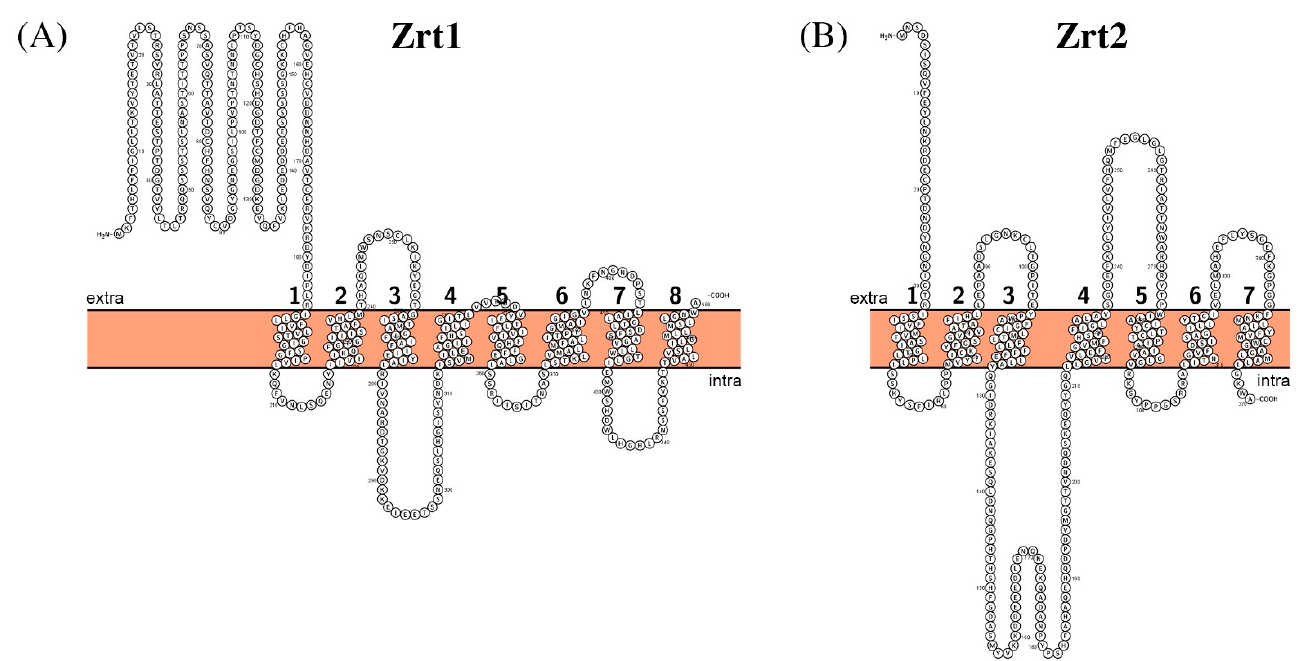
Figure 7. Schematic representation of the proposed secondary structure and topology of Zrt1 ( A ) and Zrt2 ( B ).